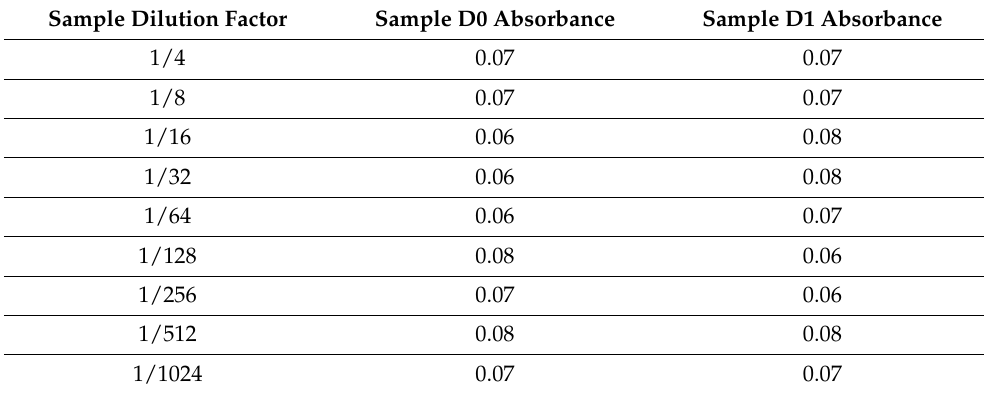
Table 1. The absorbance result obtained at D0 and D1 for the patient according to the serum dilutions. Sample Dilution Factor